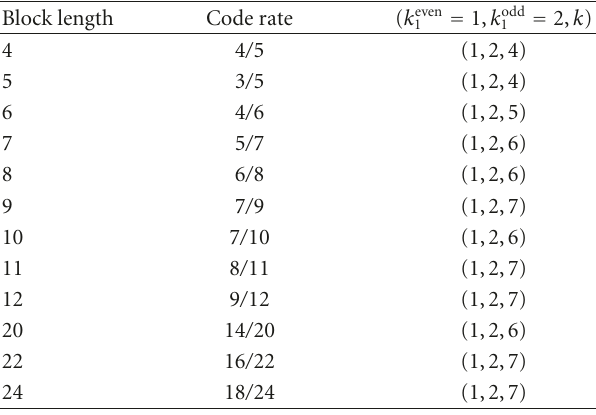
Table 1: Practical code rates of ( k even 1 = 1, k odd 1 = 2, k ) codes.